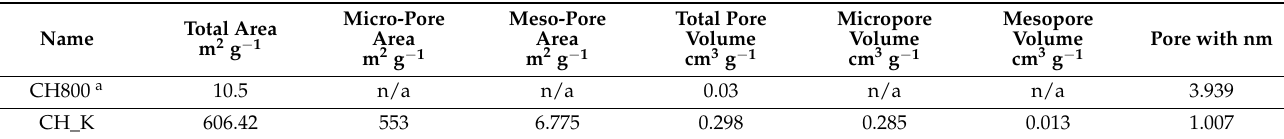
Table 1. Summary of BET surface area and pore volumes.